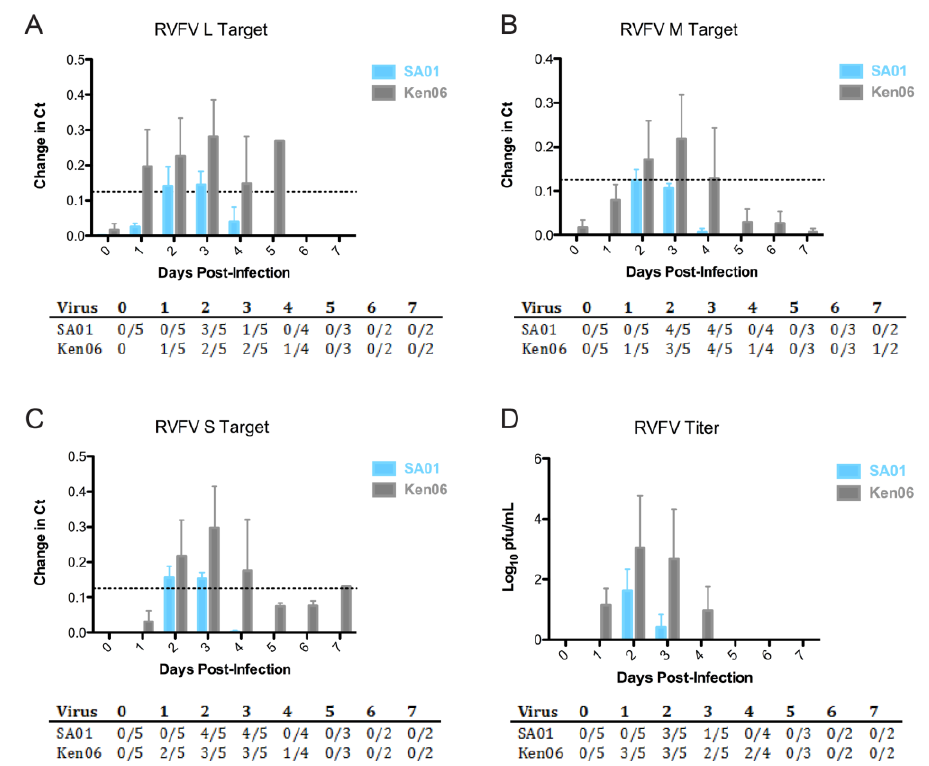
Figure 1. Kinetics of viral RNA and virus titers for calves infected with RVFV strains, SA01 (blue) and Ken06 (gray). The mean with the standard deviation of change in Ct values; (40-Ct)/40 ( A ) RVFV L RNA segment (dashed line indicates standard Ct = 35 cut-off or 0.13 change in Ct), ( B ) RVFV M RNA segment and ( C ) RVFV S RNA segment from calf serum are shown; ( D ) viral titers in pfu/mL. To be considered positive by the multiplex real-time RT-PCR, the Ct value for at least two of the three RVFV genome segments must be less than or equal to 35 [36].